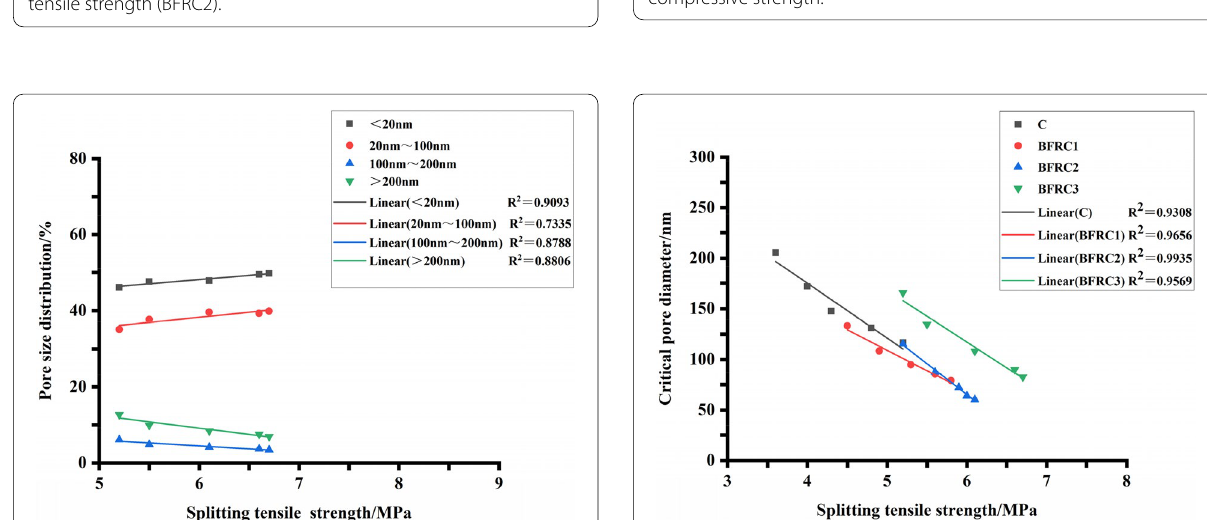
Fig. 25 Relationship between pore size distribution and splitting tensile strength (BFRC2).